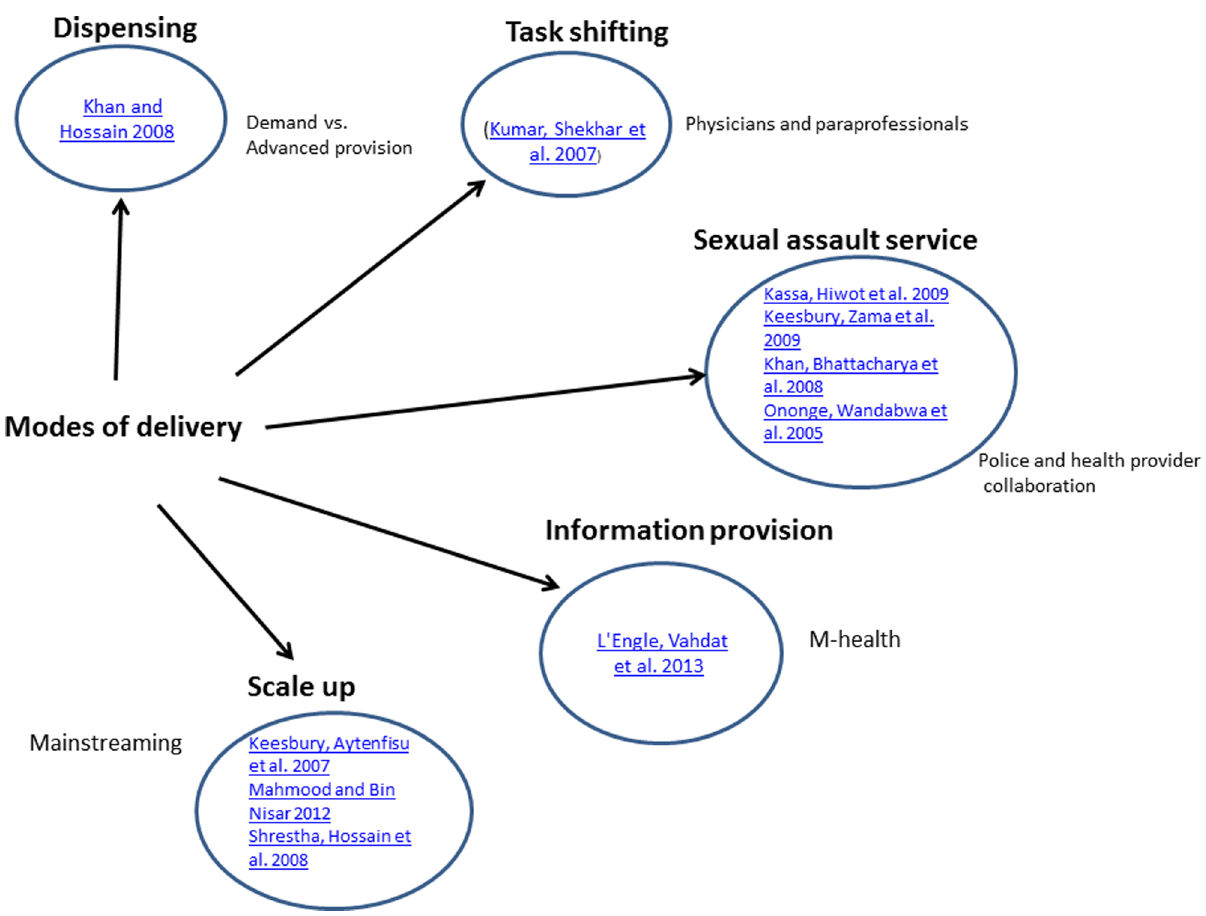
Table 3. Summary of scaling-up and mainstreaming interventions in studies in the review.